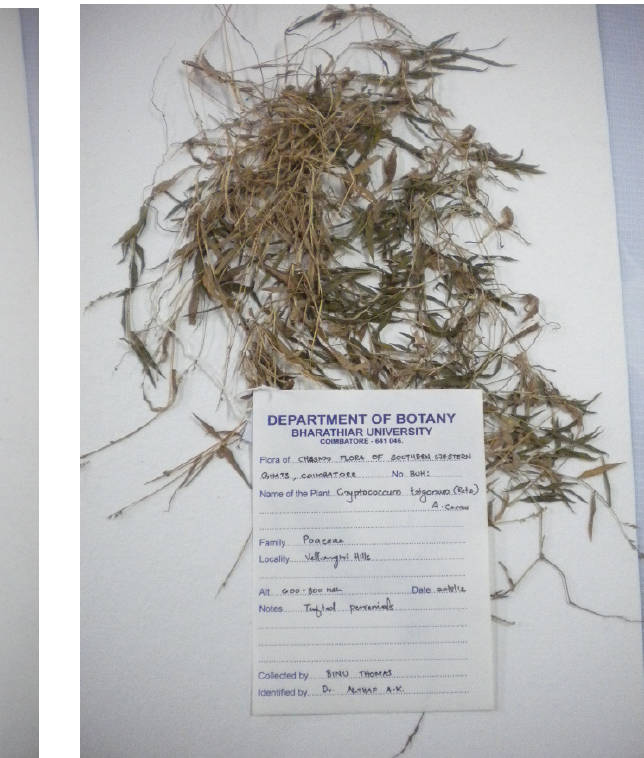
Image 14. Cymbopogon flexuosus (Nees ex Steud.) Will. Image 15. Cryptococcum trigonum (Retz.) A.